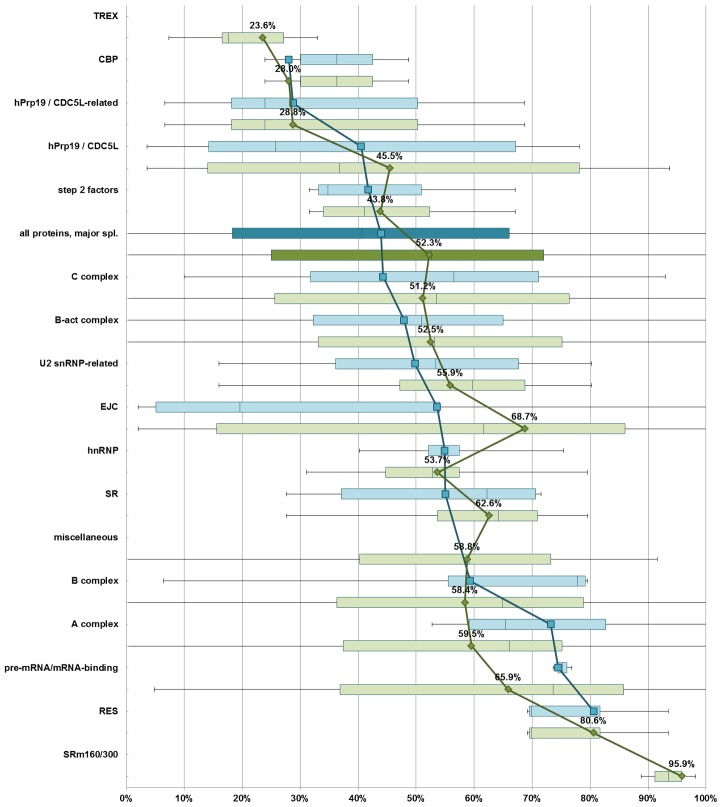
Disorder in core vs. non-abundant spliceosome proteins.Blue bars indicates values of intrinsic disorder content for core proteins, green bars for both core and additional spliceosome proteins. The blue and green lines indicate means for given protein groups, calculated per-residue. In deeper shade, values for all core (blue) and all (green) proteins associated with the major spliceosome.